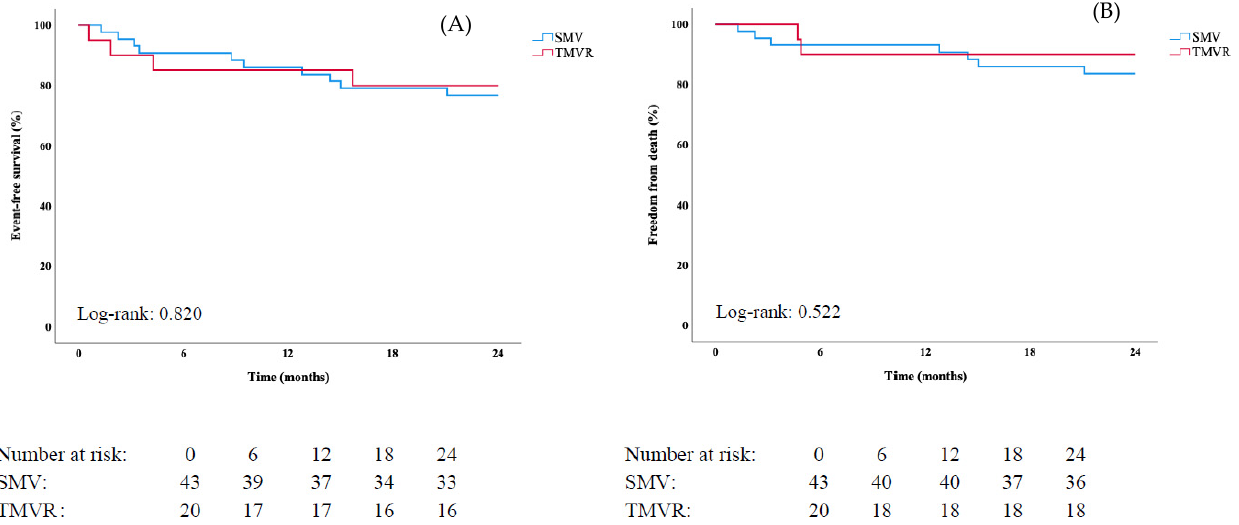
Figure 3. Kaplan-Meier curves stratified for type of intervention (surgical mitral valve treatment: SMV, transcatheter mitral valve repair: TMVR) regarding ( A ) the primary composite endpoint (heart failure hospitalization/death), and ( B ) all-cause death in patients with degenerative mitral regurgitation (MR) in the matched cohort ( n = 63).